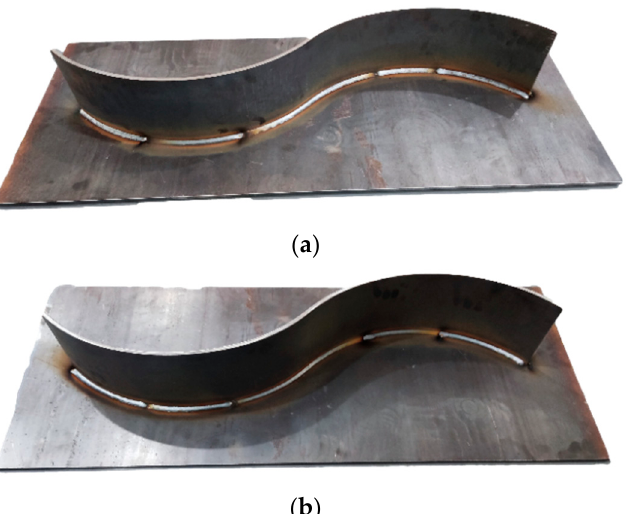
Figure 21. Welded product under the welding sequence “ ③④②⑤①⑥ ”: ( a ) front view;( b ) reverse view.